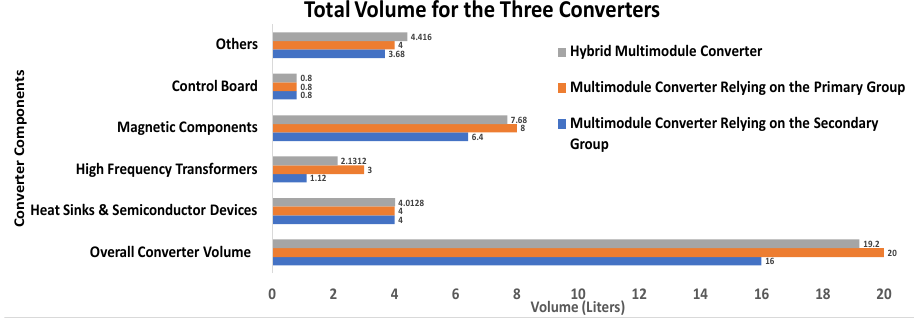
Figure 9. Converter components volume contribution in liters considering soft-switching operation.